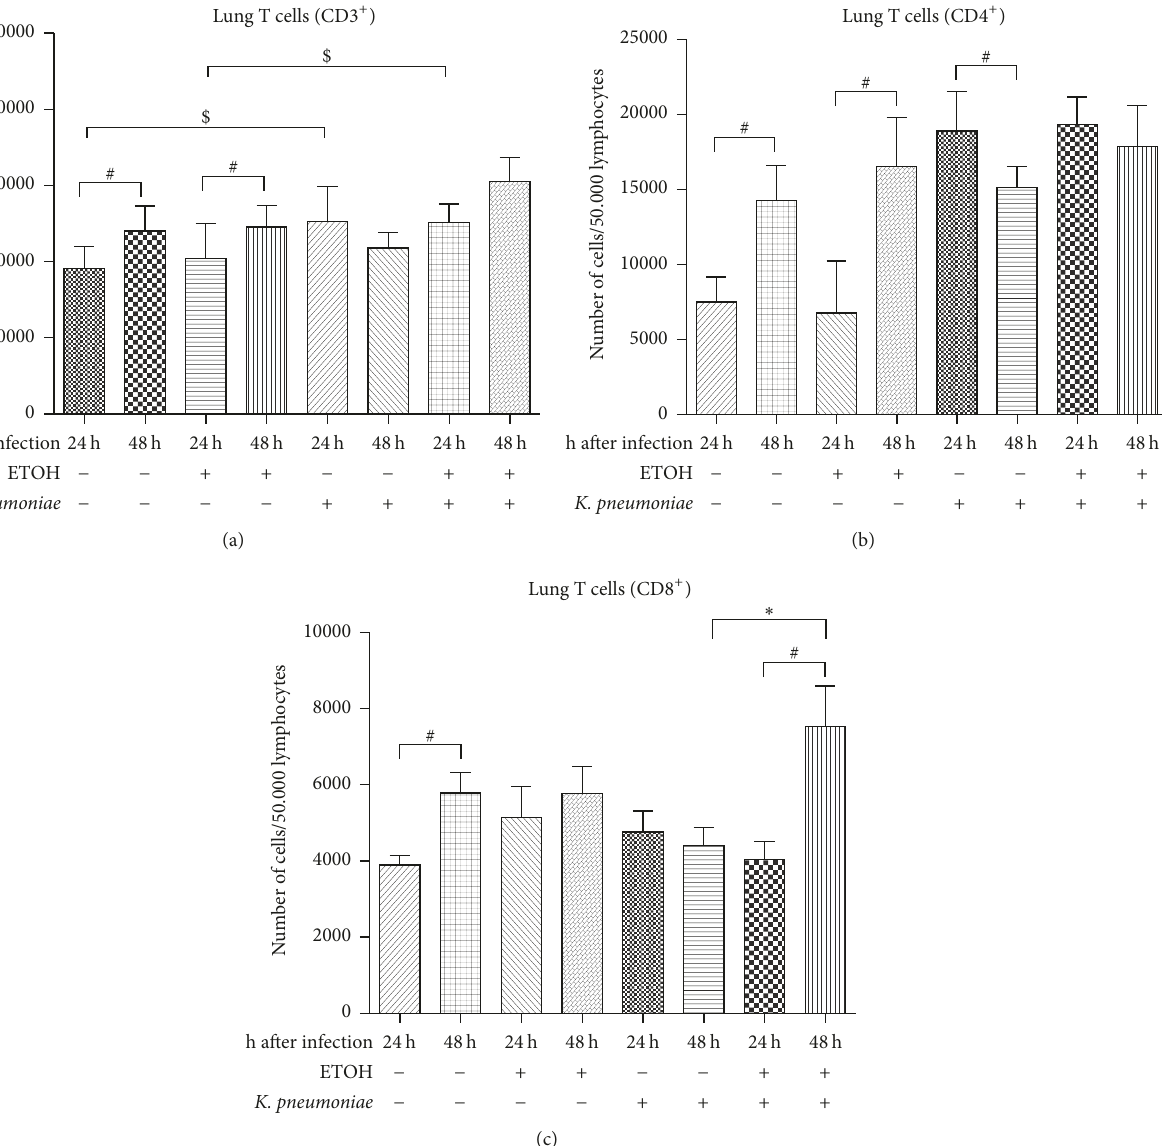
Figure4:FlowcytometricanalysisoflungandsplenicTlymphocytesubsetsinamurinemodelofethanolexpositionfor2weeks,surgery,and pulmonary infection. (a) Flow cytometric analysis of CD3+ cells in the lung in ethanol-treated (ETOH) and saline-treated controls